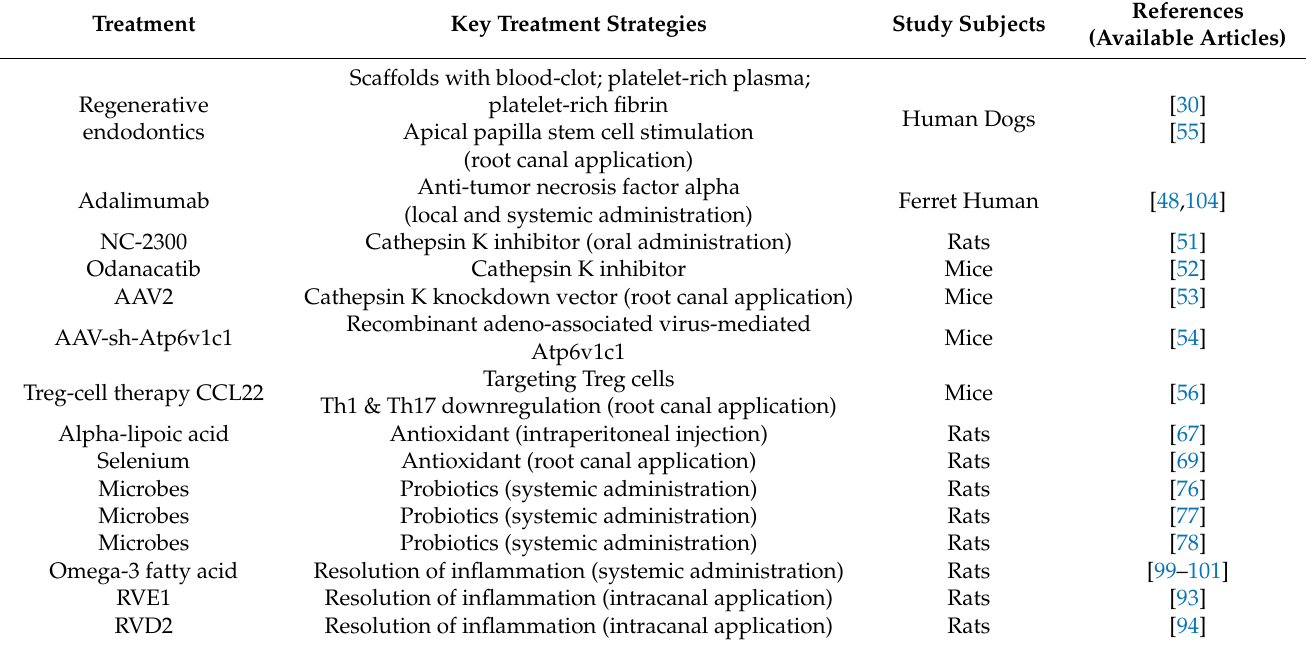
Table 1. Recent advances in the treatment of apical